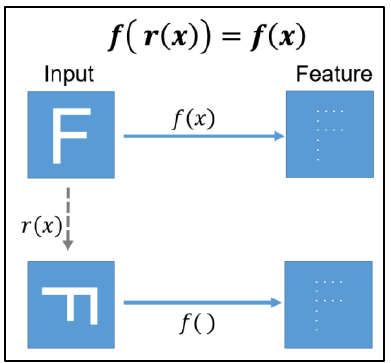
Figure 1. Rotational invariance.